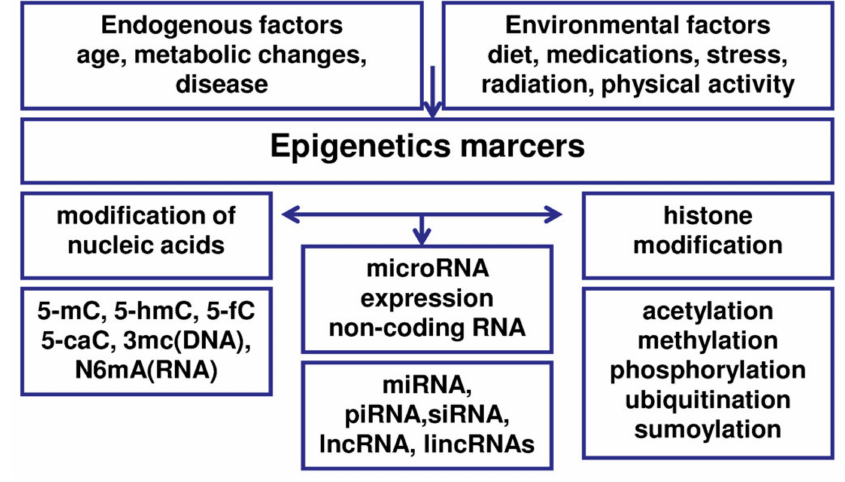
Figure 2. Epigenetic regulation of gene expression in